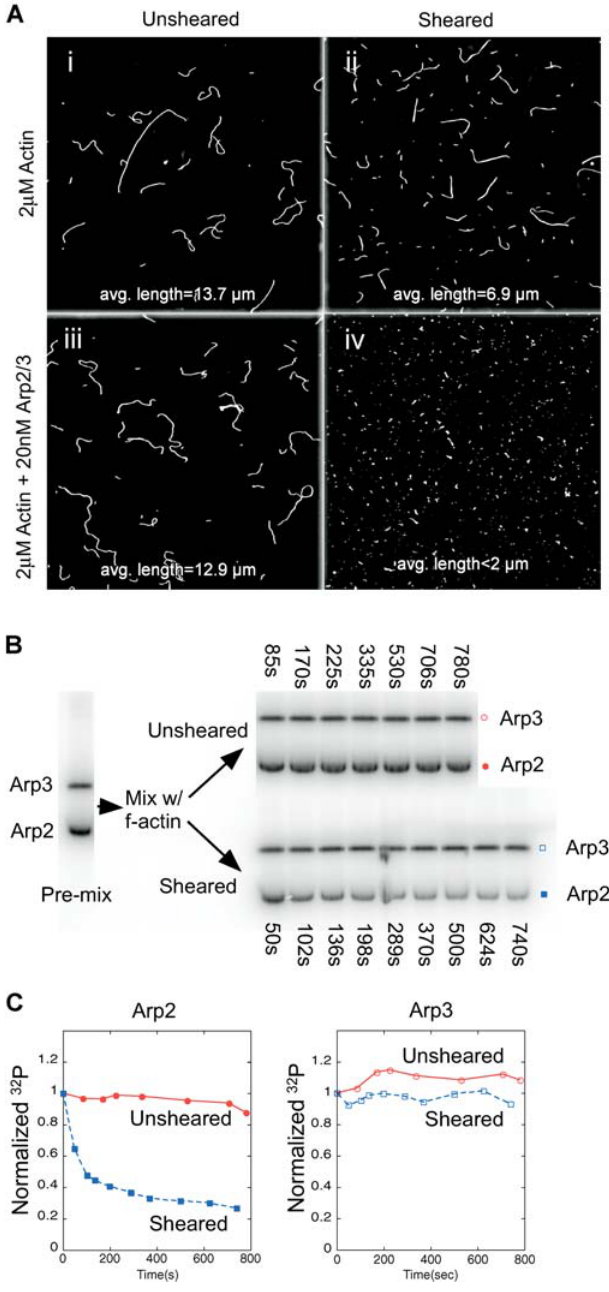
Figure 4. Pointed-End Filament Capping Is Sufficient to Stimulate ATP Hydrolysis on Arp2 in the Absence of VCA (A) The Arp2/3 complex prevents actin filament reannealing by capping the pointed ends. The length distribution of 2 l M Alexa-488 phalloidin-stabilized actin filaments is unaffected in the absence (i) or presence (iii) of 20 nM Arp2/3 complex. (ii) 5 min after shearing the filaments, filaments have begun to reanneal in the absence of the Arp2/3 complex, but 20 nM Arp2/3 complex (iv) maintains short filaments, preventing reannealing by capping filament pointed ends. (B) ATP hydrolysis on Arp2 is stimulated by pointed-end capping. Crosslinked c - 32 P-AzidoATP-Arp2/3 (20 nM) was mixed with 2 l M phalloidin-stabilized actin filaments. The mixture was split in two and one sample was sheared. Timepoints were taken as shown. (C) Uncleaved 32 P on Arp2 (unsheared [closed circle] and sheared [closed square]) and Arp3 (unsheared [open circle] and sheared [open square]) were quantified from (B). Arp2 rapidly hydrolyzes bound ATP upon filament pointed-end capping. DOI: 10.1371/journal.pbio.0020091.g004 PLoS Biology |